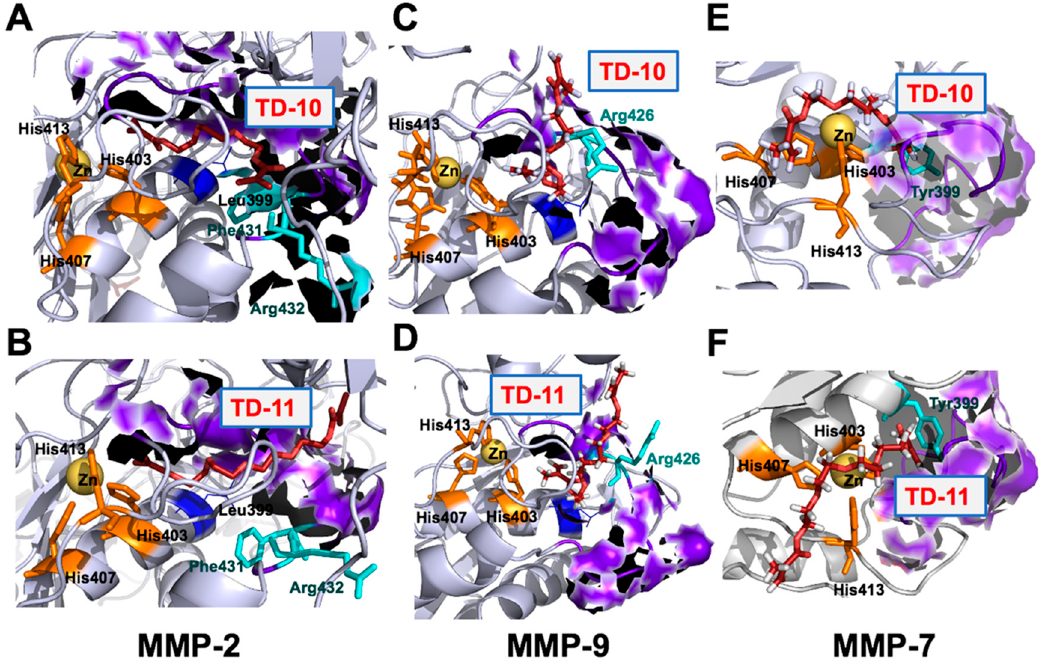
Figure 5. Interaction of TD-10 and TD-11 with S1’ pocket of MMP-2 ( A , B ), MMP-9 ( C , D ) and MMP-7 ( E , F ), respectively. S1’ pocket residues surfaces are highlighted in purple color and gatekeeper residues of S1’ pocket shown in cyan color. Three histidine residues that coordinate catalytic Zn ion are shown in orange color.